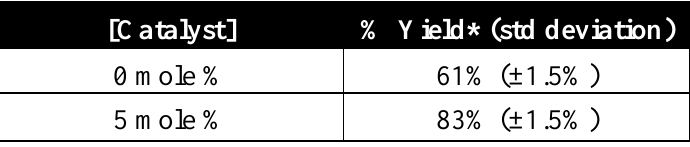
Table 1. Aqueous Diels-Alder